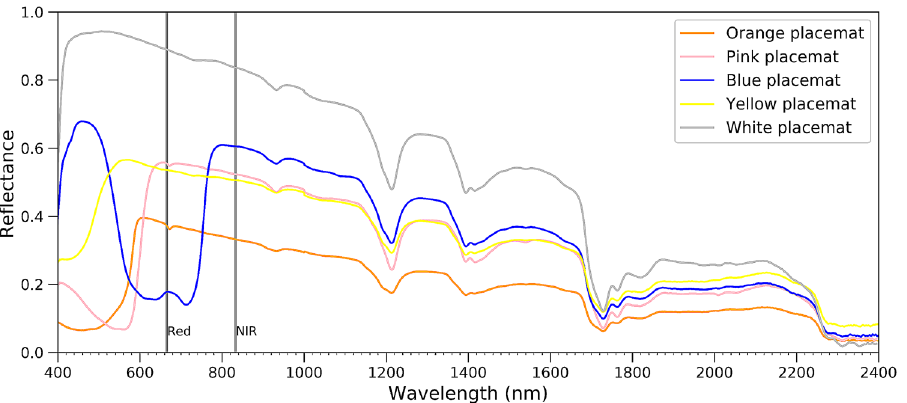
Figure 7. Spectral reflectance of dry virgin placemats in different